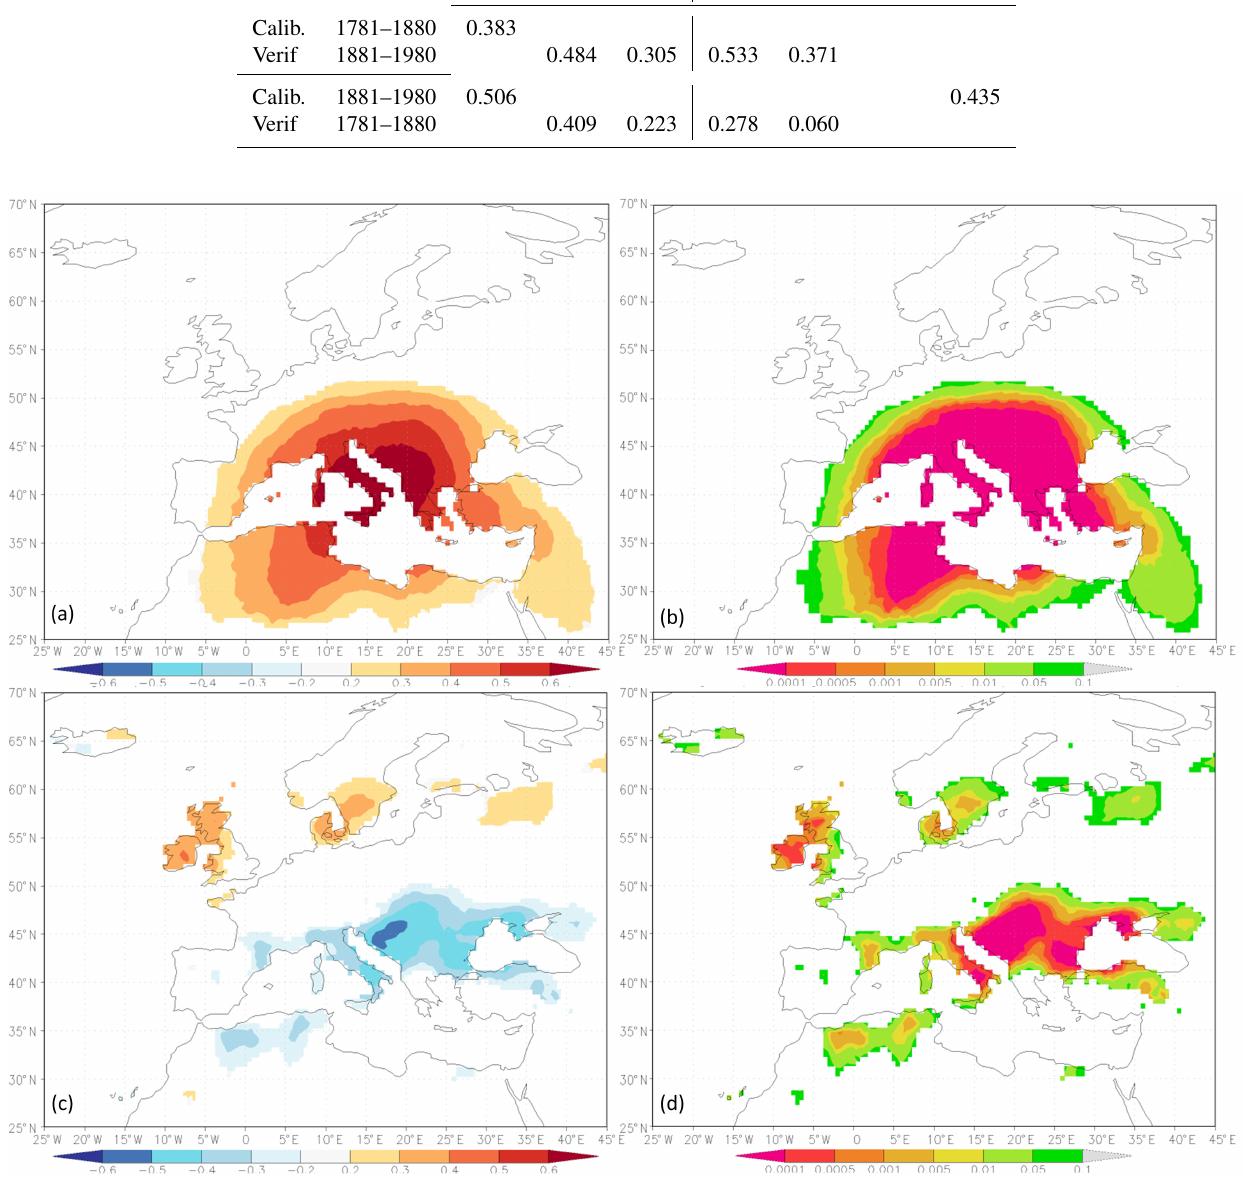
Figure 7. Spatial correlation pattern of the reconstructed late summer temperature (using the MXD chronology from the Italian Peninsula) versus the 0.5 ◦ grid CRU TS 4.0 August–September mean temperature (a, b) and mean precipitation (c, d) , over the period of 1901–1980. Left side (a, c) Pearson’s correlation coefficients; right side (b, d) the associated p